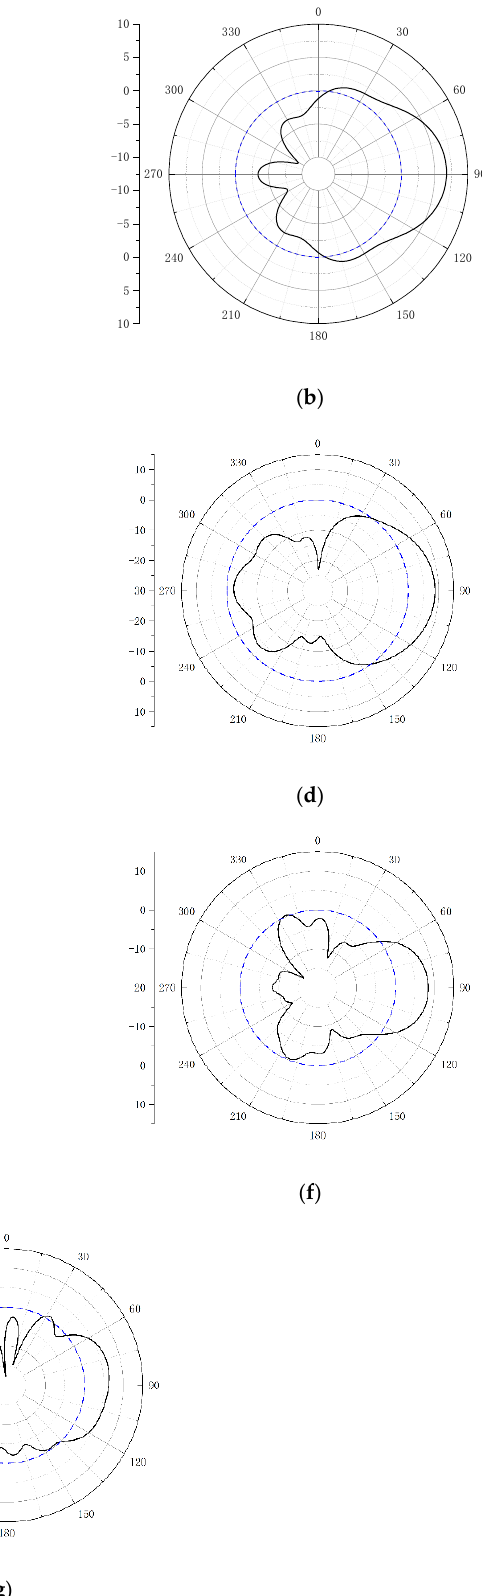
Figure 6. E-plane pattern of narrow beam Vivaldi antenna with structure at ( a ) 2 GHz; ( b ) 3 GHz; and ( c ) 4 GHz; ( d ) 5 GHz; ( e ) 6 GHz ( f ) 7 GHz; ( g ) 8 GHz.